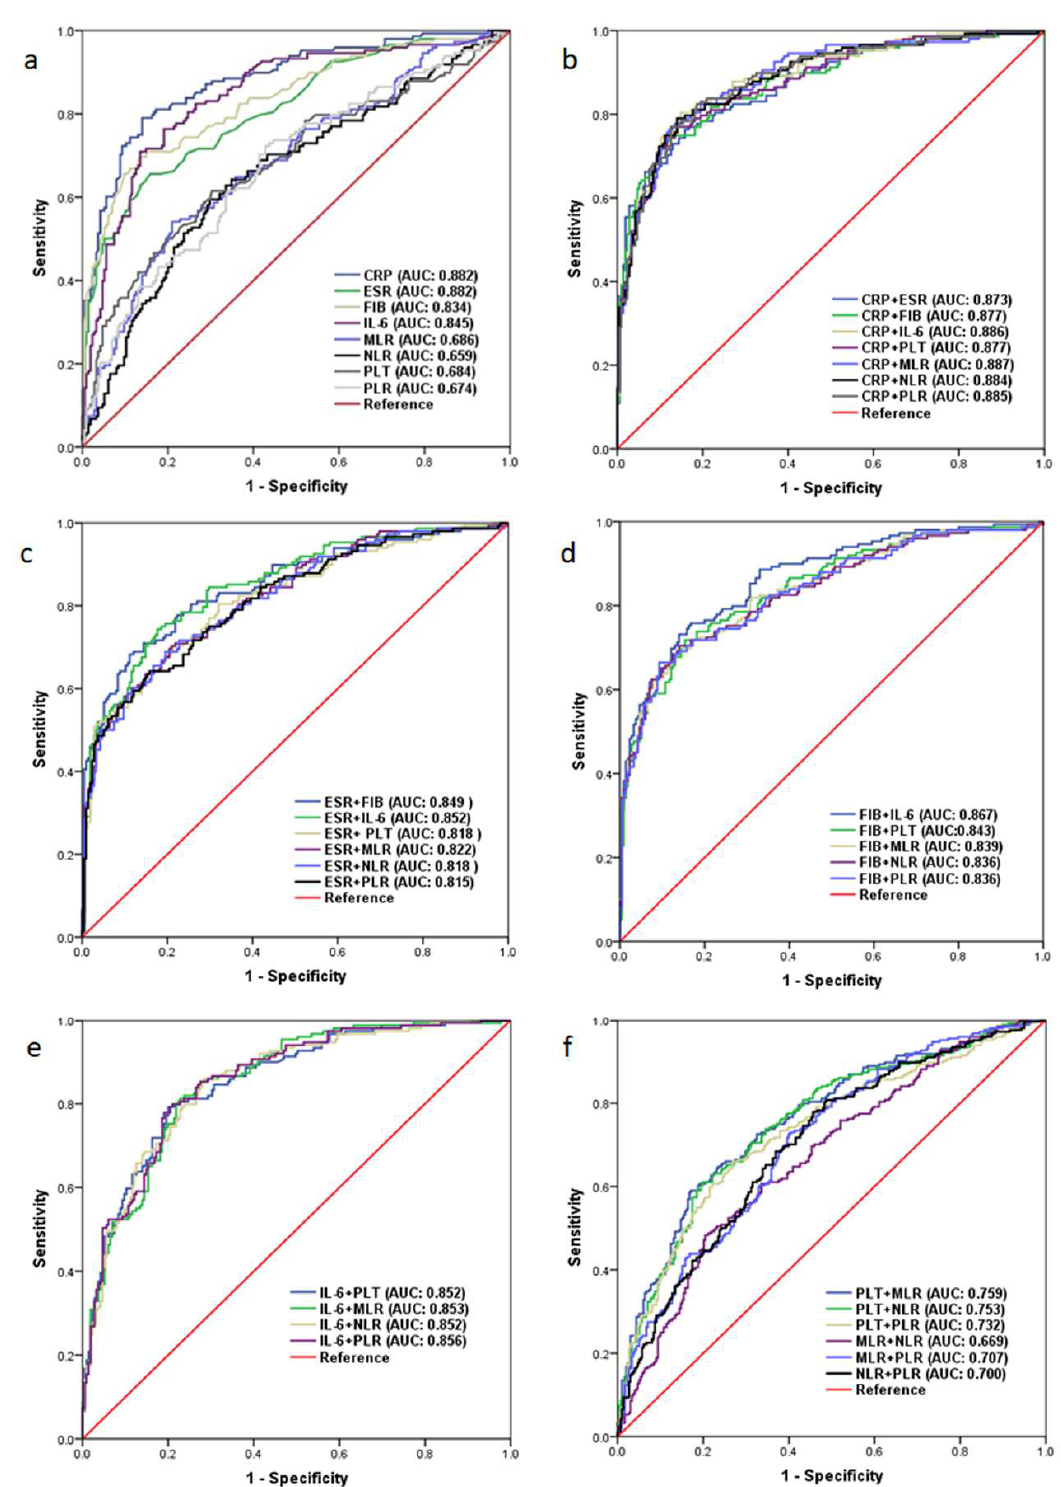
Figure 2. Receiver operating characteristic curves of the tested biomarkers. ( a ) C-reactive protein (CRP), erythrocyte sedimentation rate (ESR), fibrinogen (FIB), interleukin-6 (IL-6), platelet count (PLT), monocyte/lymphocyte ratio (MLR), neutrophil/lymphocyte ratio (NLR), and platelet count/lymphocyte ratio (PLR) on their own. ( b ) Combinations of CRP with other markers. ( c ) Combinations of ESR with other markers. ( d ) Combinations of FIB with other markers. ( e ) Combinations of IL-6 with other markers. ( f ) Combinations of PLT, MLR, and NLR with each other.